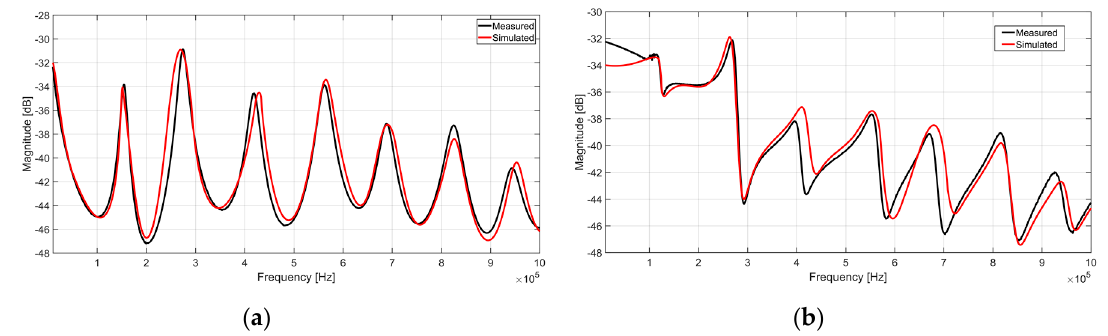
Figure 9. Comparison of measured and simulated transformer functions (TFs) for the healthy state of windings; ( a ) OC ( b ) IIW.